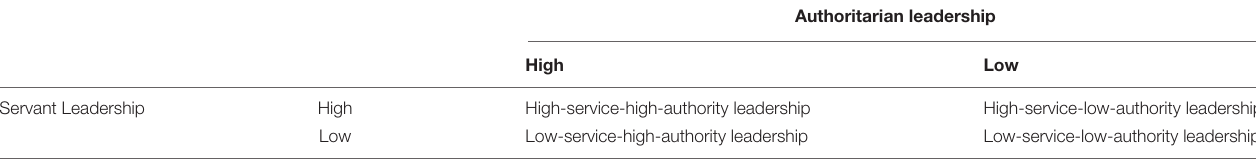
TABLE 1 | Four combinations of ambidextrous